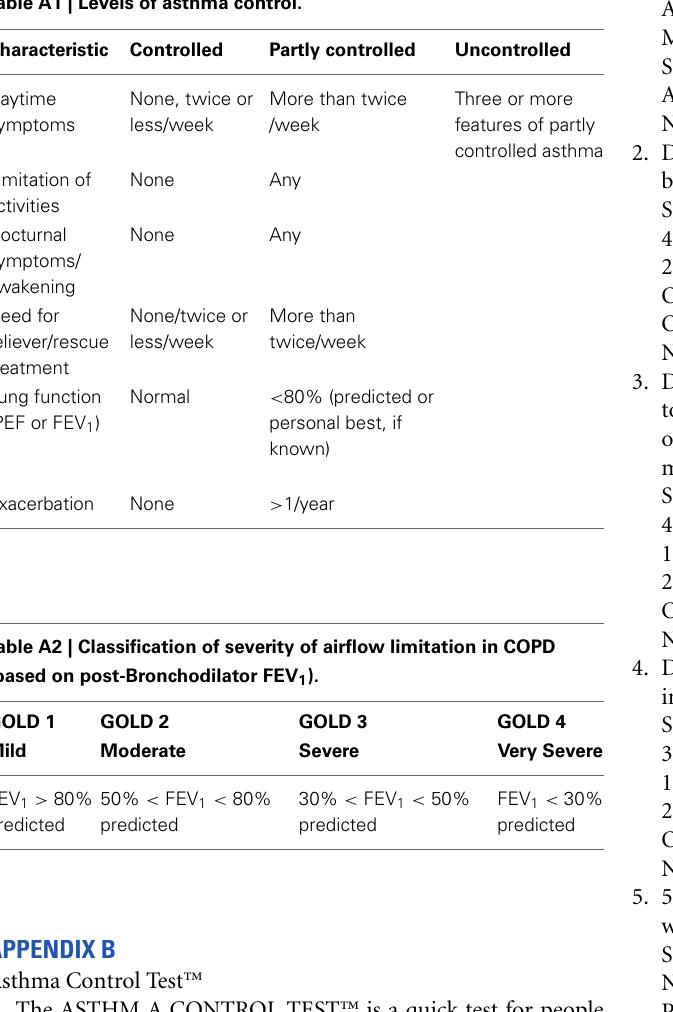
Table A1 | Levels of asthma control.